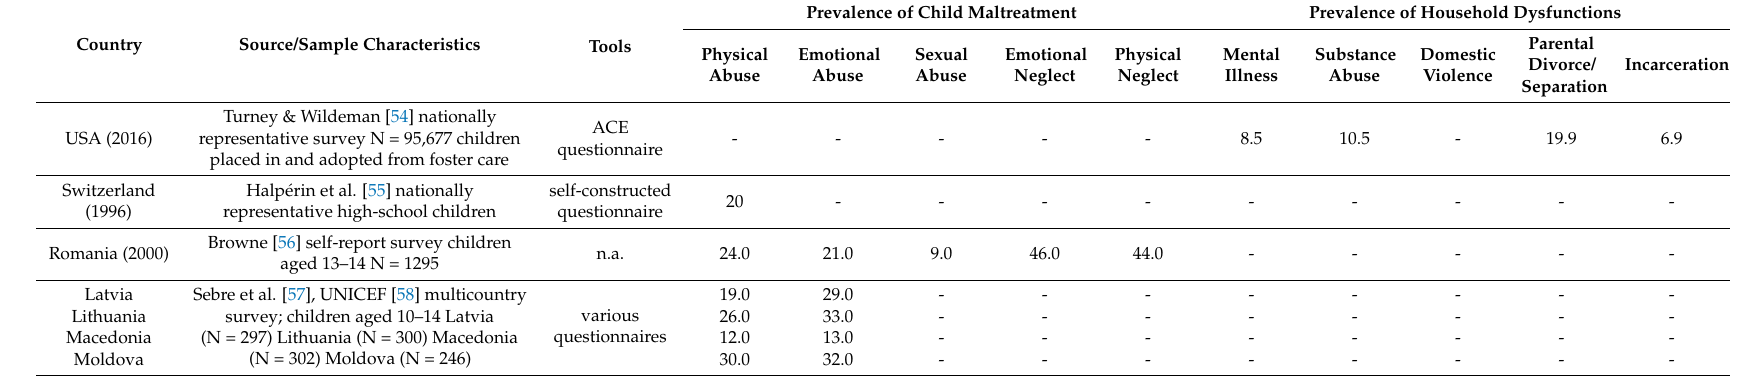
Table 9. A comparison of prevalence rates (estimates and measured data) of child maltreatment across the globe reported by children.